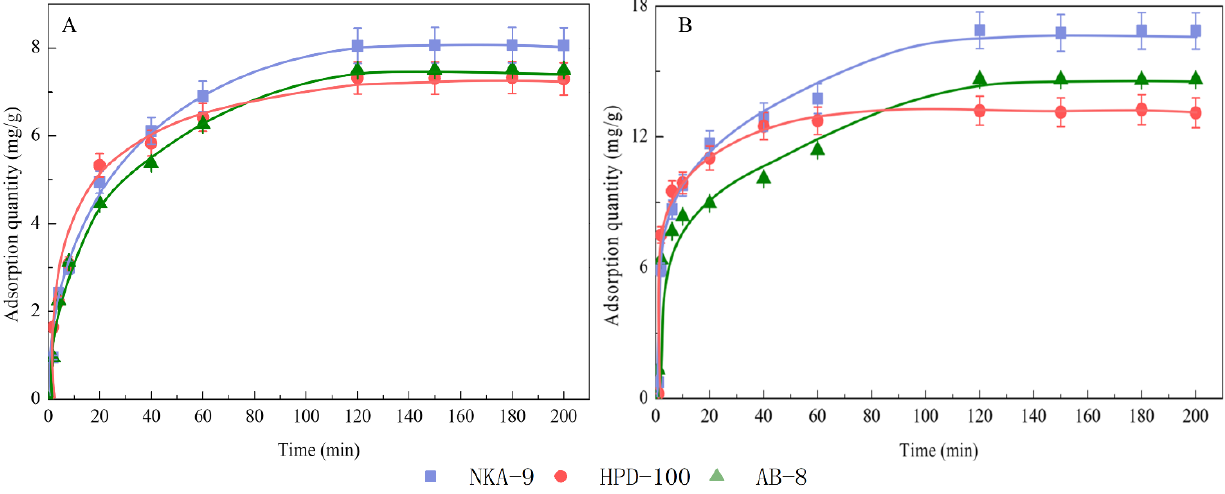
Figure 4. Static adsorption-desorption of polyphyllin II ( A ) and polyphyllin VII ( B ) on seven res- ins.